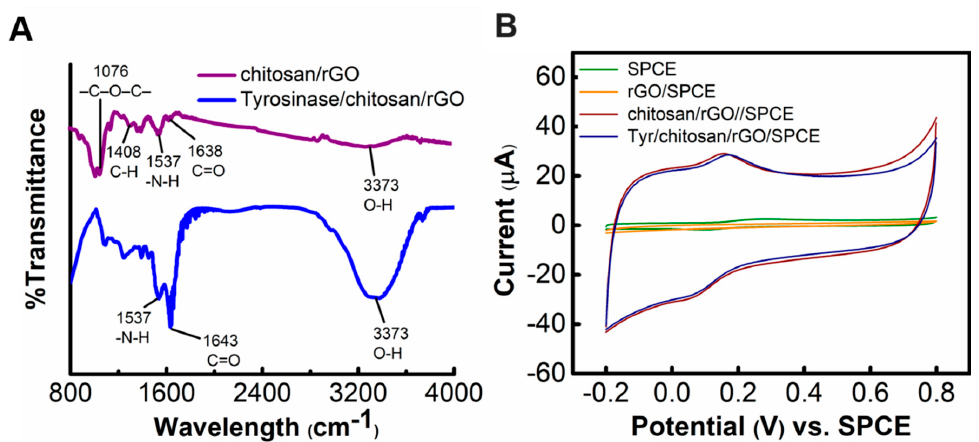
Figure 2. ( A ) ATR-FTIR spectra of chitosan modified electrode with tyrosinase (blue line) and without tyrosinase (purple line). ( B ) Cyclic voltammetry (CV) responses (at a scan rate of 100 mVs − 1 ) of the different electrodes in the presence of 10 µ M of dopamine